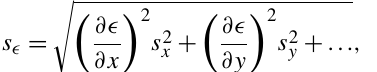
Algorithm 1 Calculating denudation rates on a pixel-by- pixel basis.